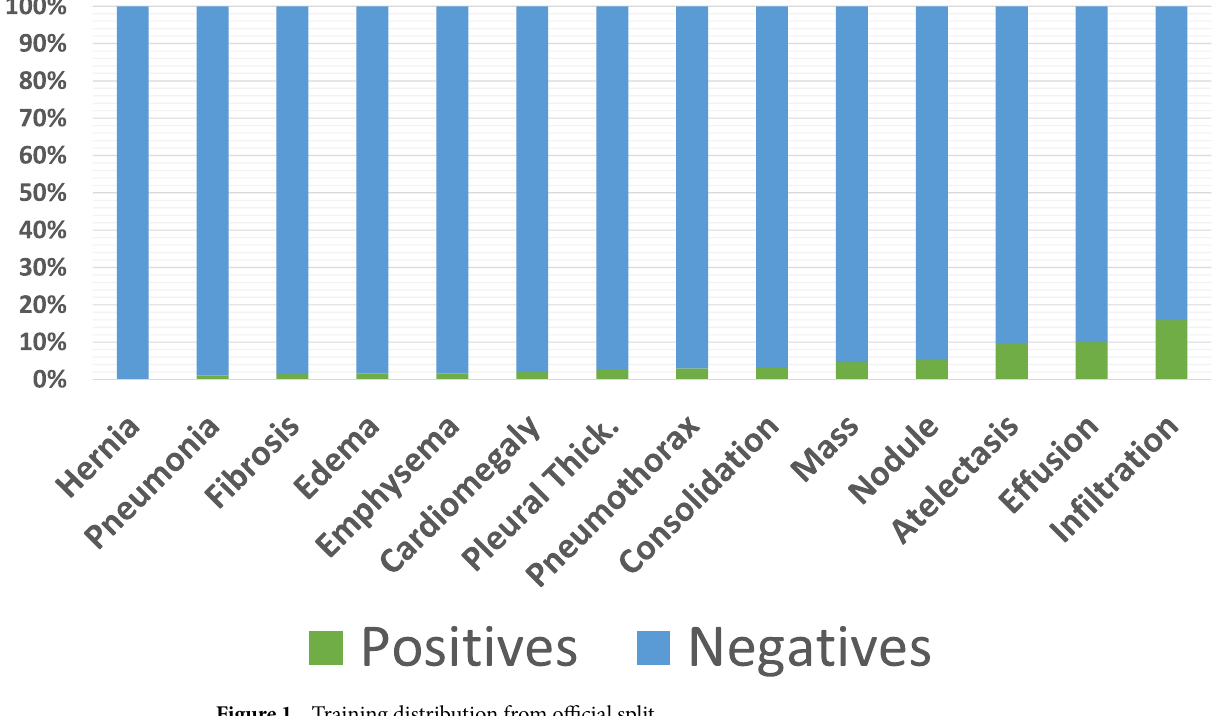
Figure 1. Training distribution from official